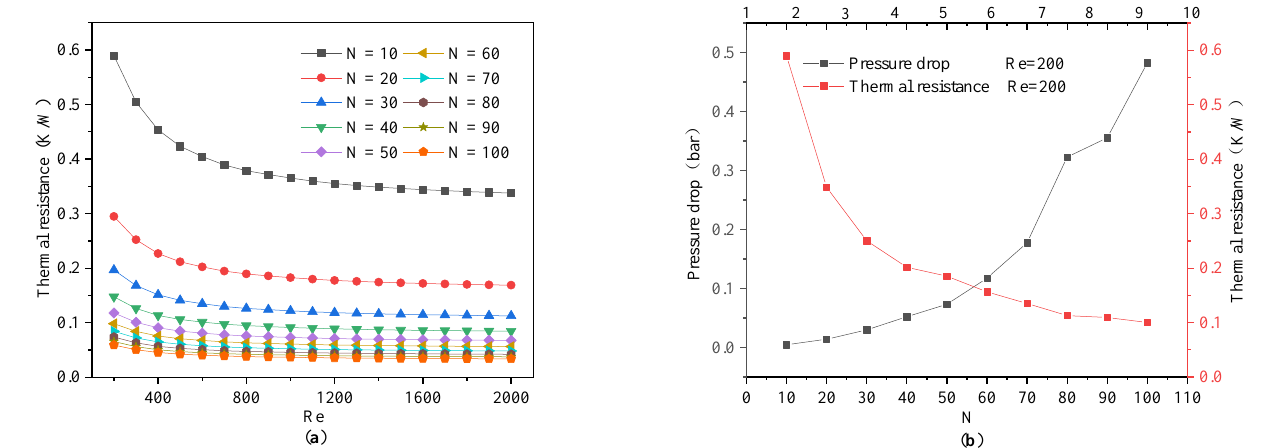
Figure 13. Temperature field along x – z of the top of microchannel heat sinks with different cross- section shapes ( D h = 0.417 mm, W pp = 0.27 W) ( a ). Temperature field and velocity flow diagram along x – z middle cross-sections of different microchannels ( D h = 0.417 mm, W pp = 0.27 W) ( b ).